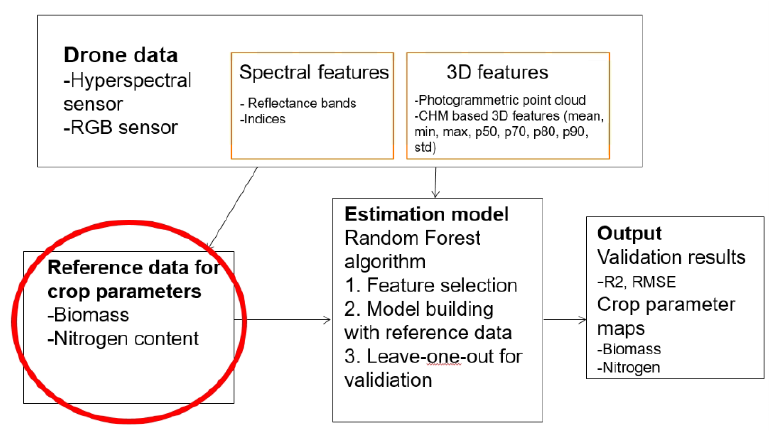
Figure 8. Reference data are crucial when machine learning-based methods are developed for crop parameter estimation (modified figure originally published in [13]). parameter estimation (modified figure originally published in